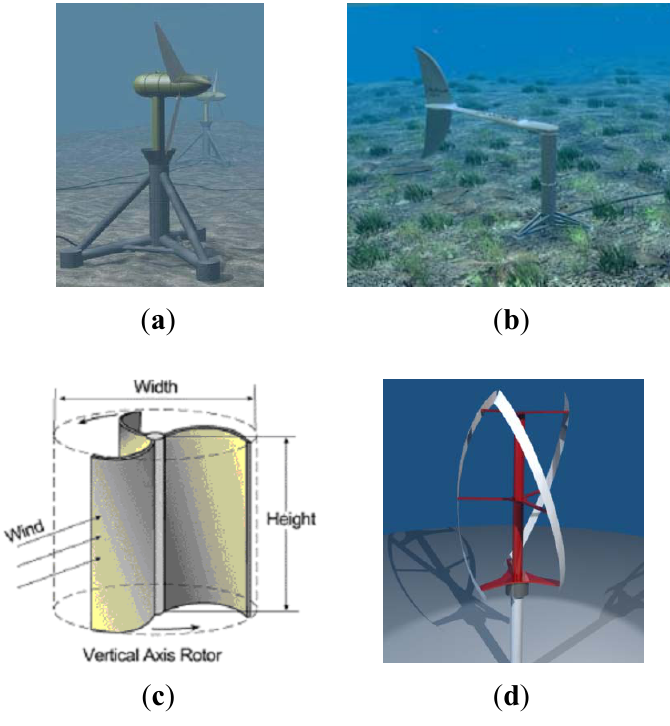
Figure 5. Tidal Turbines. From left to right are the ( a ) Swanturbine ® , ( b ) By-ostream ® , ( c ) Savonius ® , and ( d ) Gorlov ®